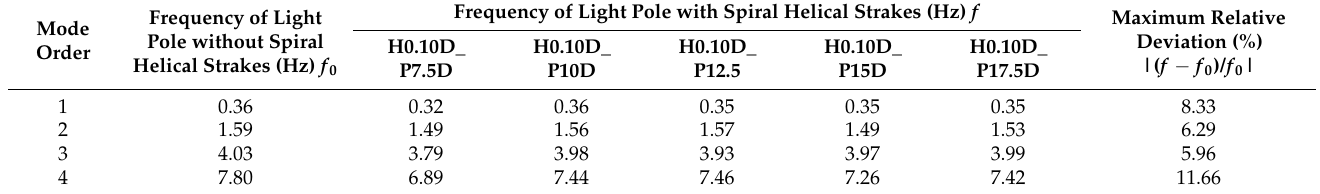
Table 4. Comparison of the first four-mode frequencies of the light pole under different pitch conditions.